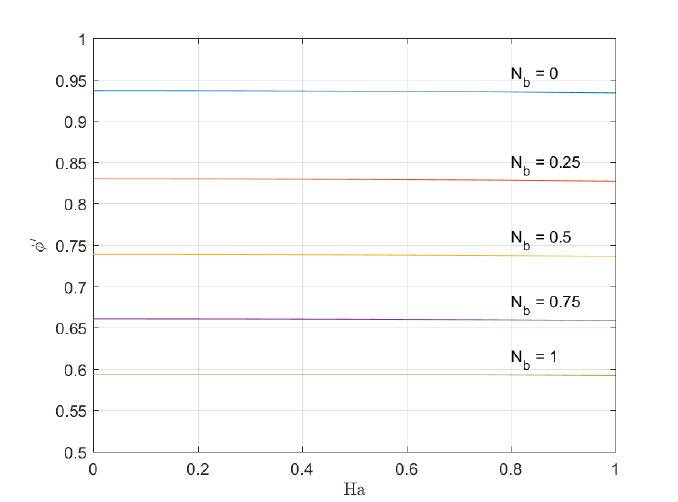
Figure 6. MHD and Brownian diffusion parameter effects on the rate of the chemical reaction in the